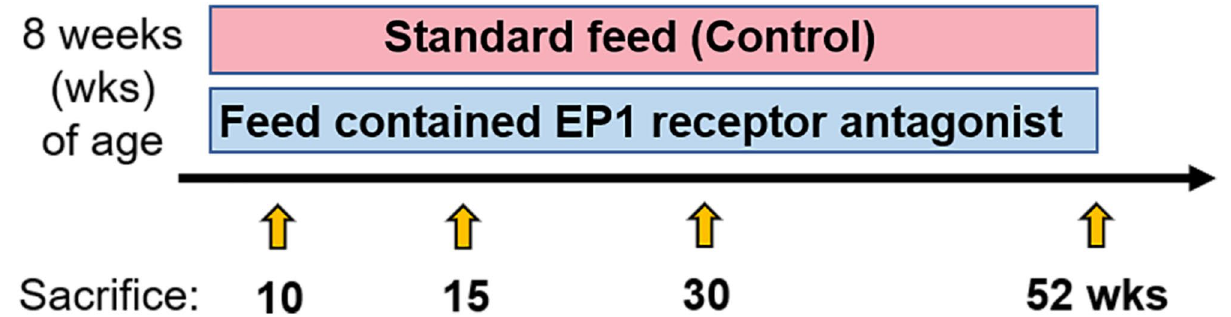
Figure 1. Summary of the animal experiments. Mice were fed with or without EP1 receptor antagonist from 8 weeks of age, and mice were sacrificed at 10, 15, 30, and 52 weeks of